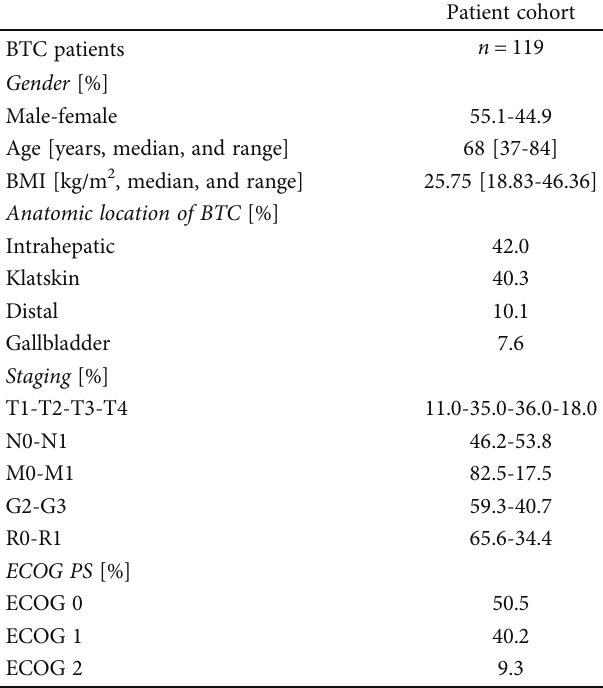
Table 1: Patient